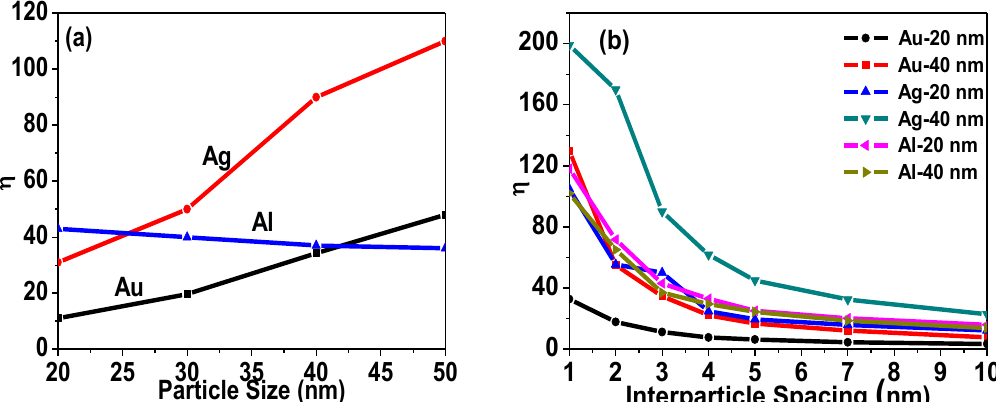
Figure 6: (a) Size dependent and (b) Interparticle spacing dependent  for homo-dimer nanostructure.